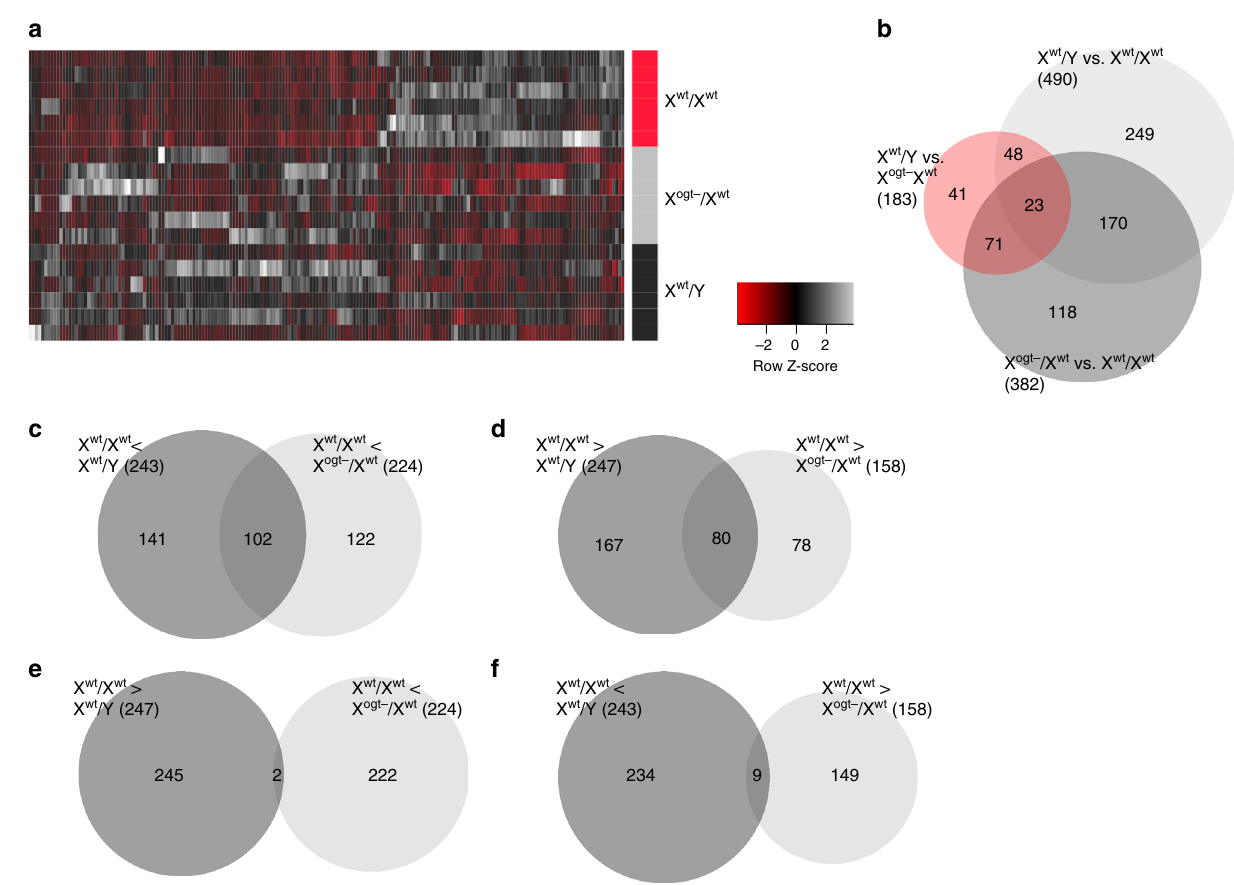
Fig. 2 Gene expression patterns are masculinized in the E18.5 female hypothalamus by placental Ogt reduction. a Heatmap of mRNAs with sex differences in hypothalamic expression (490 genes, FDR adjusted p < 0.05) in trophoblast X wt /X wt , X ogt − /X wt , X wt /Y at E18.5. Expression patterns of hypothalmic genes (columns) with sex differences were mimicked by Ogt reduction in female trophoblasts (individual placentas = rows). Z -scores plotted across individuals for each gene. b Venn diagram displaying the number of differentially expressed genes in the hypothalamus of animals with X wt /Y vs. X wt /X wt ( n = 490 genes), X ogt − /X wt vs. X wt /Y ( n = 182 genes), and X ogt − /X wt vs. X wt /X wt ( n = 381 genes) trophoblasts and the number of differentially expressed genes common in these groups. c – f Venn diagrams displaying overlapping directional changes in hypothalamic gene expression in trophoblast X wt /X wt , X ogt − /X wt , X wt /Y fetuses. c A total of 102 genes enriched in the X wt /Y male hypothalamus relative to X wt /X wt females were also enriched in the hypothalamus of X ogt − /X wt females. d Similarly, 80 genes enriched in the X wt /X wt females hypothalamus relative to X ogt − /X wt females were also enriched in the hypothalamus of X wt /X wt females compared to X wt /Y males. e Only 2 genes with higher hypothalamic expression in X ogt − /X wt females relative to X wt /X wt females were higher in X wt /X wt females relative to X wt /Y males. f Similarly, only 9 genes with higher hypothalamic expression in X wt /X wt